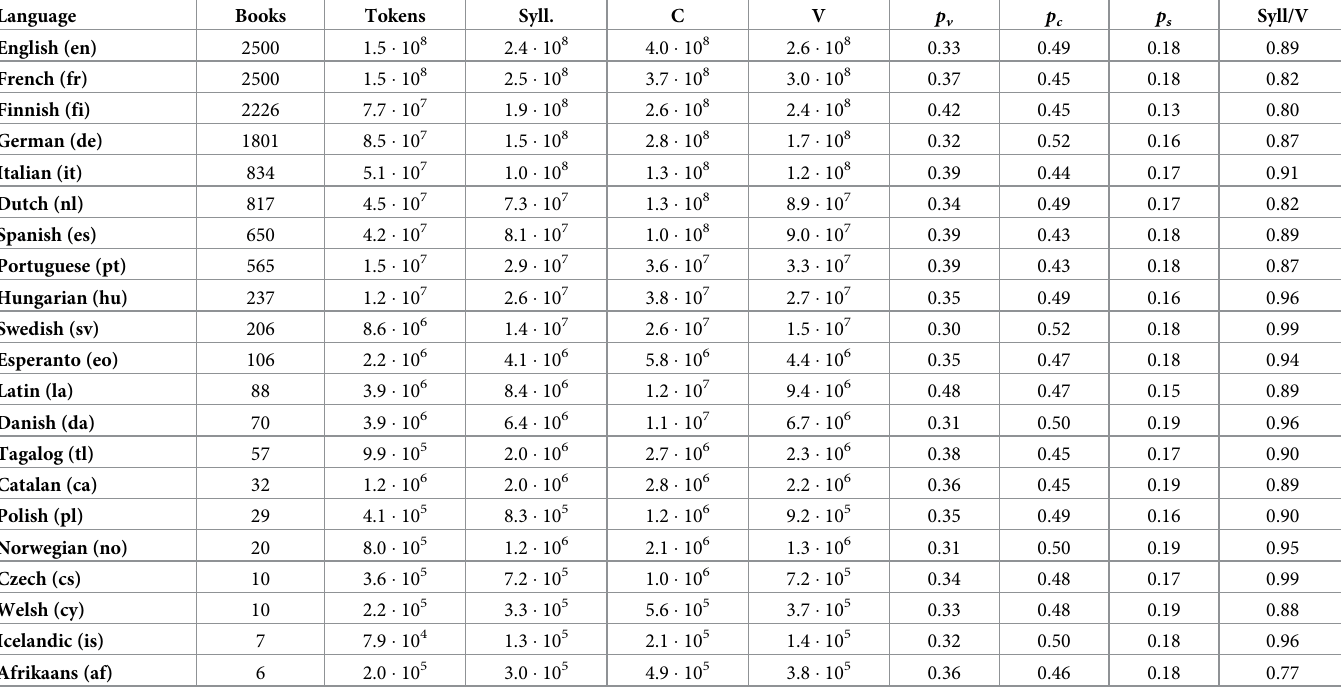
Table 2. Summary of characteristics for the 21 languages studied including the total number of books, word tokens, syllables, consonants ( C ) and vowels ( V ), as well as the probabilities of vowels ( p v ), consonants ( p c ) or spaces ( p s ). The last column ( Syll / V ) reports the syllable-vowel